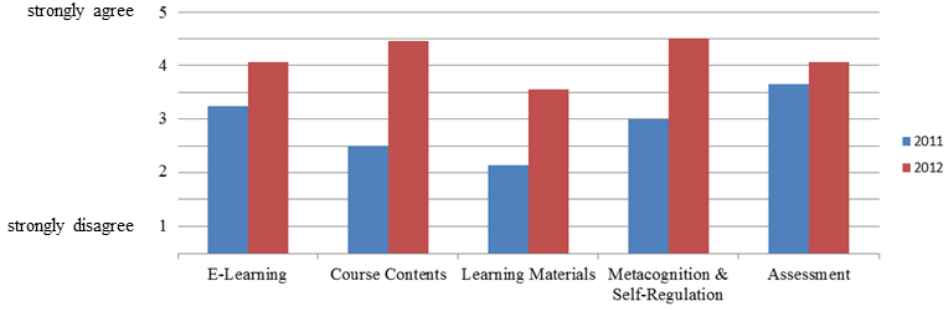
Figure 4. CE/TD survey